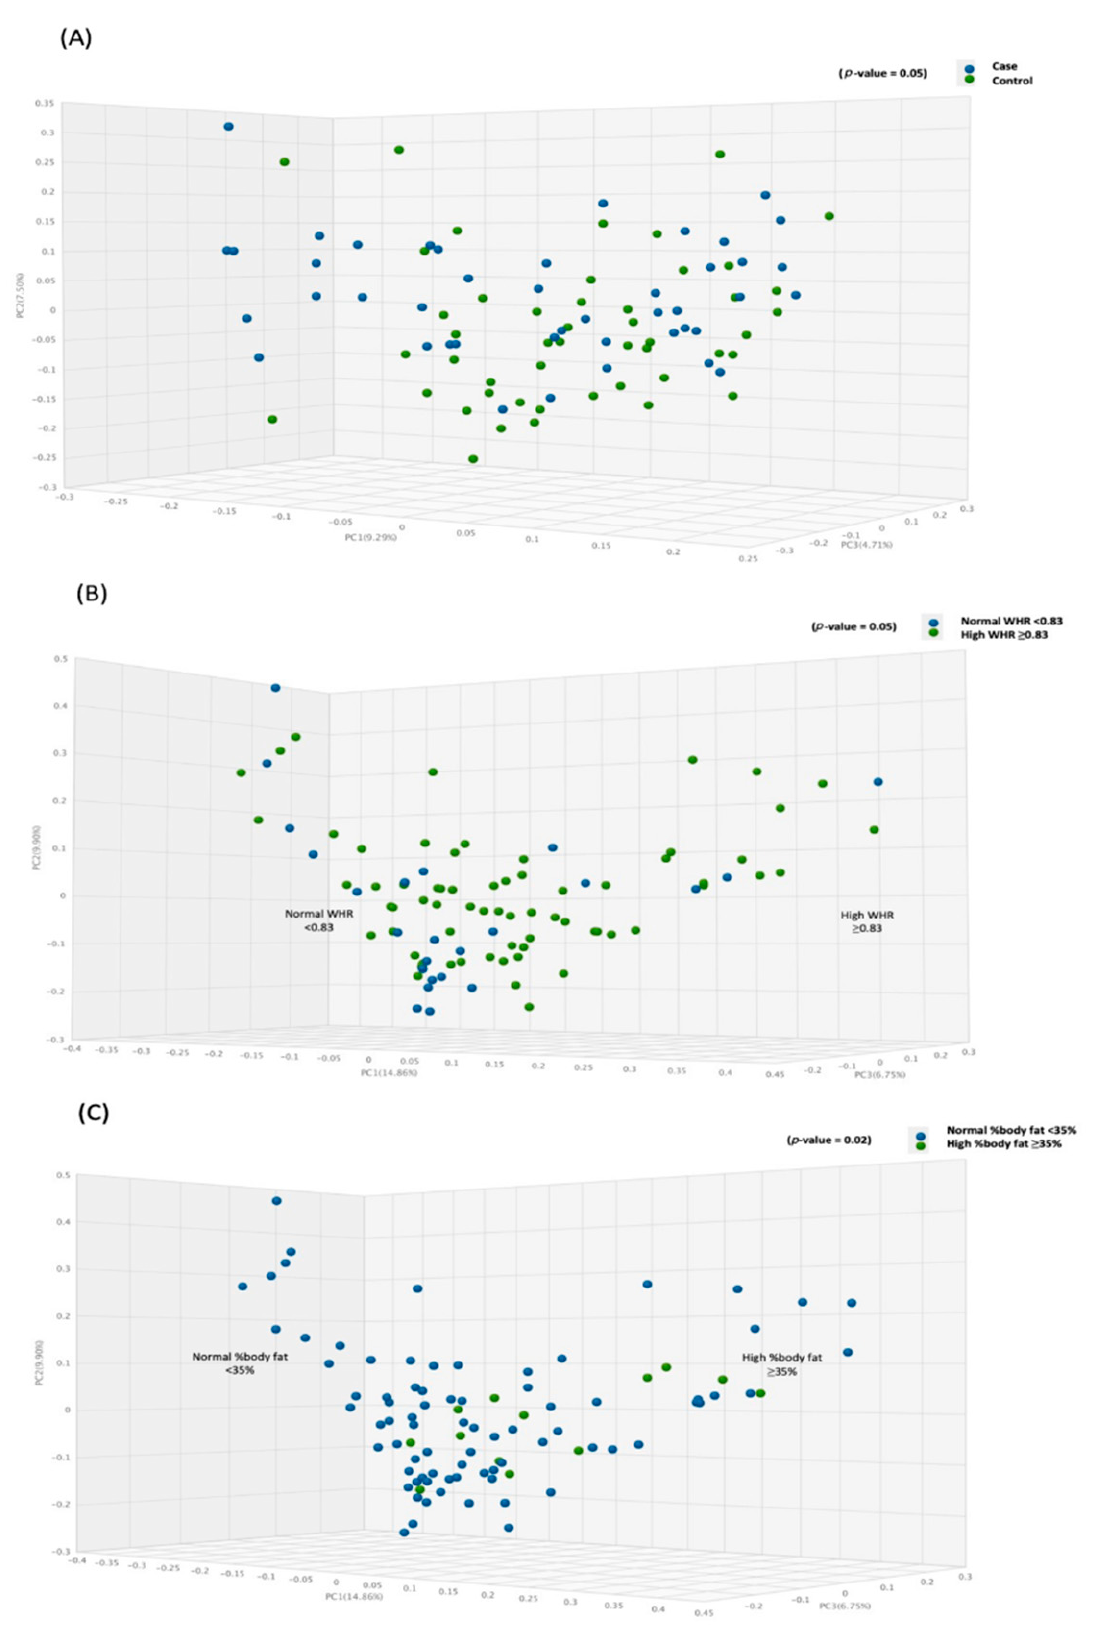
Figure 2. Comparison between gut microbiota beta diversity (PCoA) and obesity markers: ( A ) relative to the BMI, ( B ) relative to WHR, and ( C ) relative to %body fat.